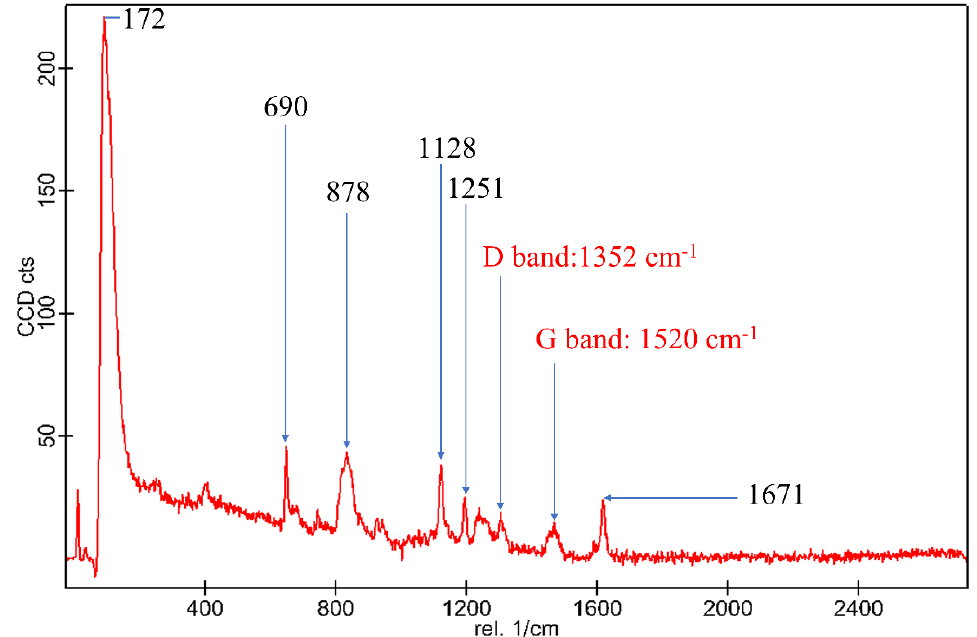
Figure 3. Raman spectrum of CNT reinforced Epoxy